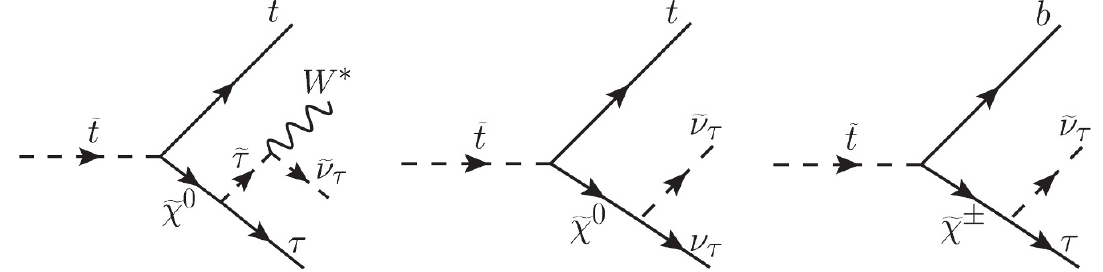
Figure 1 . The dominant stop decays in our analysis. Left diagram: production of a top, a tau and a stau, promptly decaying into soft W -boson products and missing transverse energy. Middle diagram: production of a top and two correlated sources of missing transverse energy. Right diagram: production of a bottom, tau and missing transverse